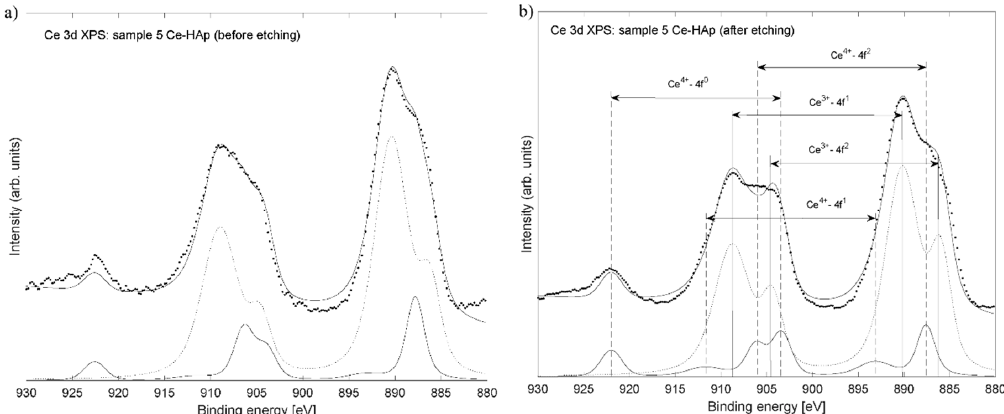
Figure 6. XPS Ce 3d regions of the 5Ce-HAp coating before ( a ) and after ( b ) etching. Upper spectra: Data and total fit after subtraction of a linear background. Lower spectra: Dotted line represents Ce 3+ and solid line represents Ce 4+ . The various components of the Ce 3+ and Ce 4+ core levels corresponding to different 4f-counts are shown in ( b ).